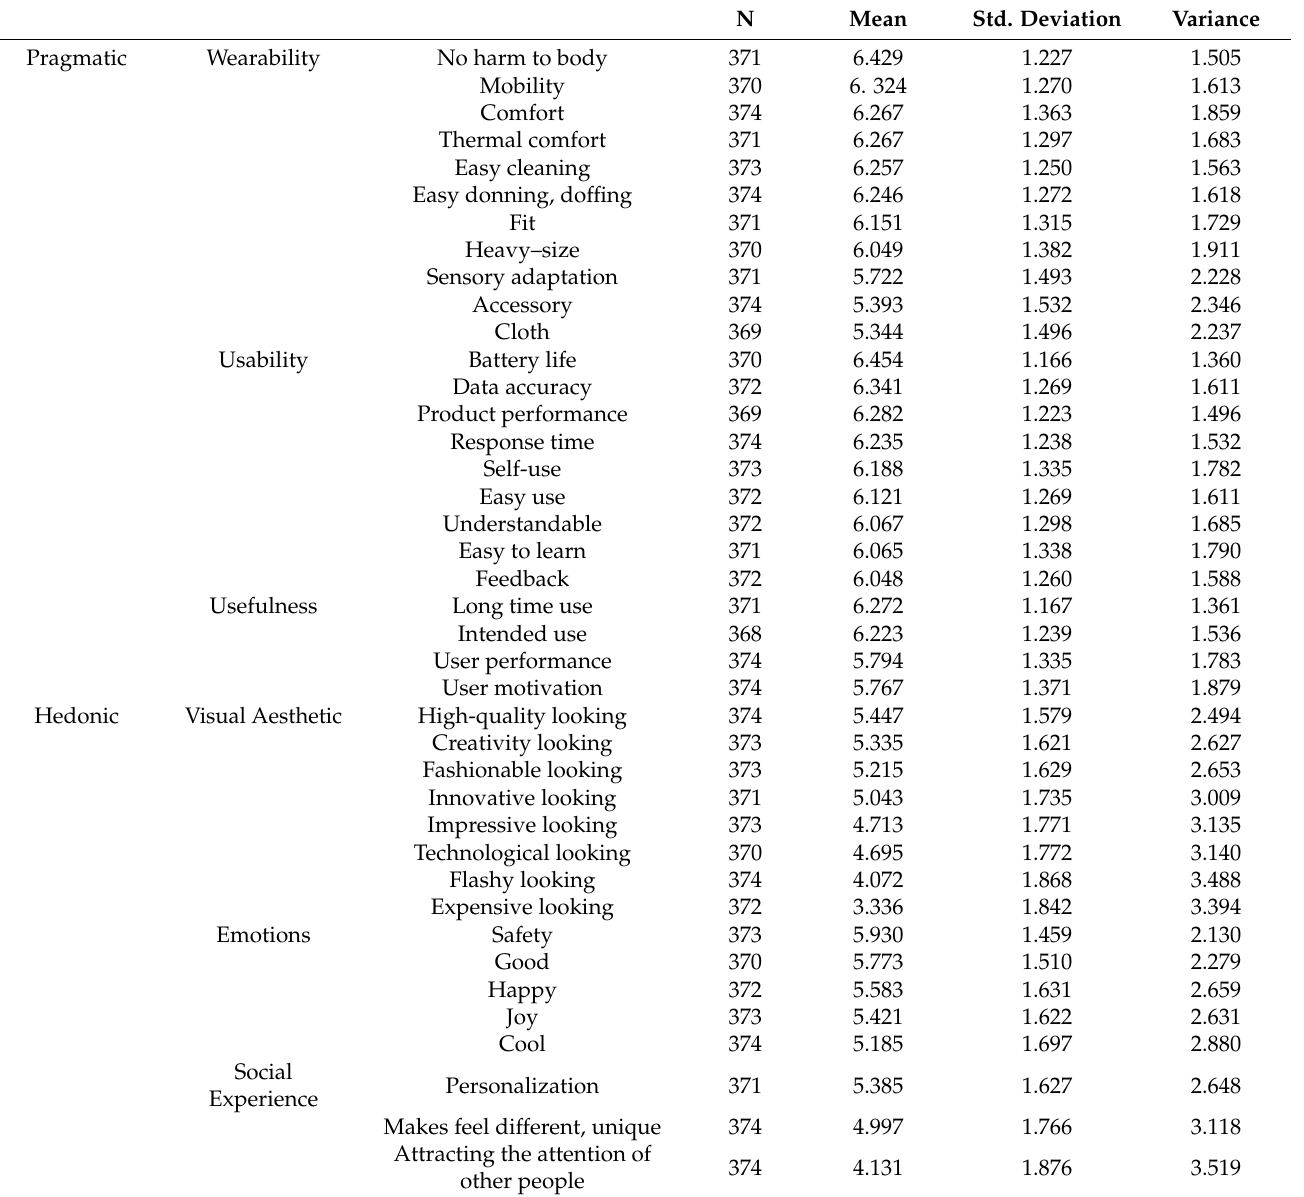
Table 1. User expectation